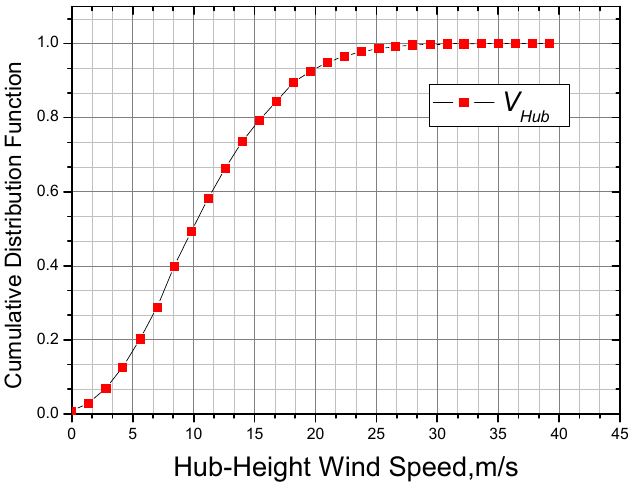
Figure 3. 3D bar plot of H